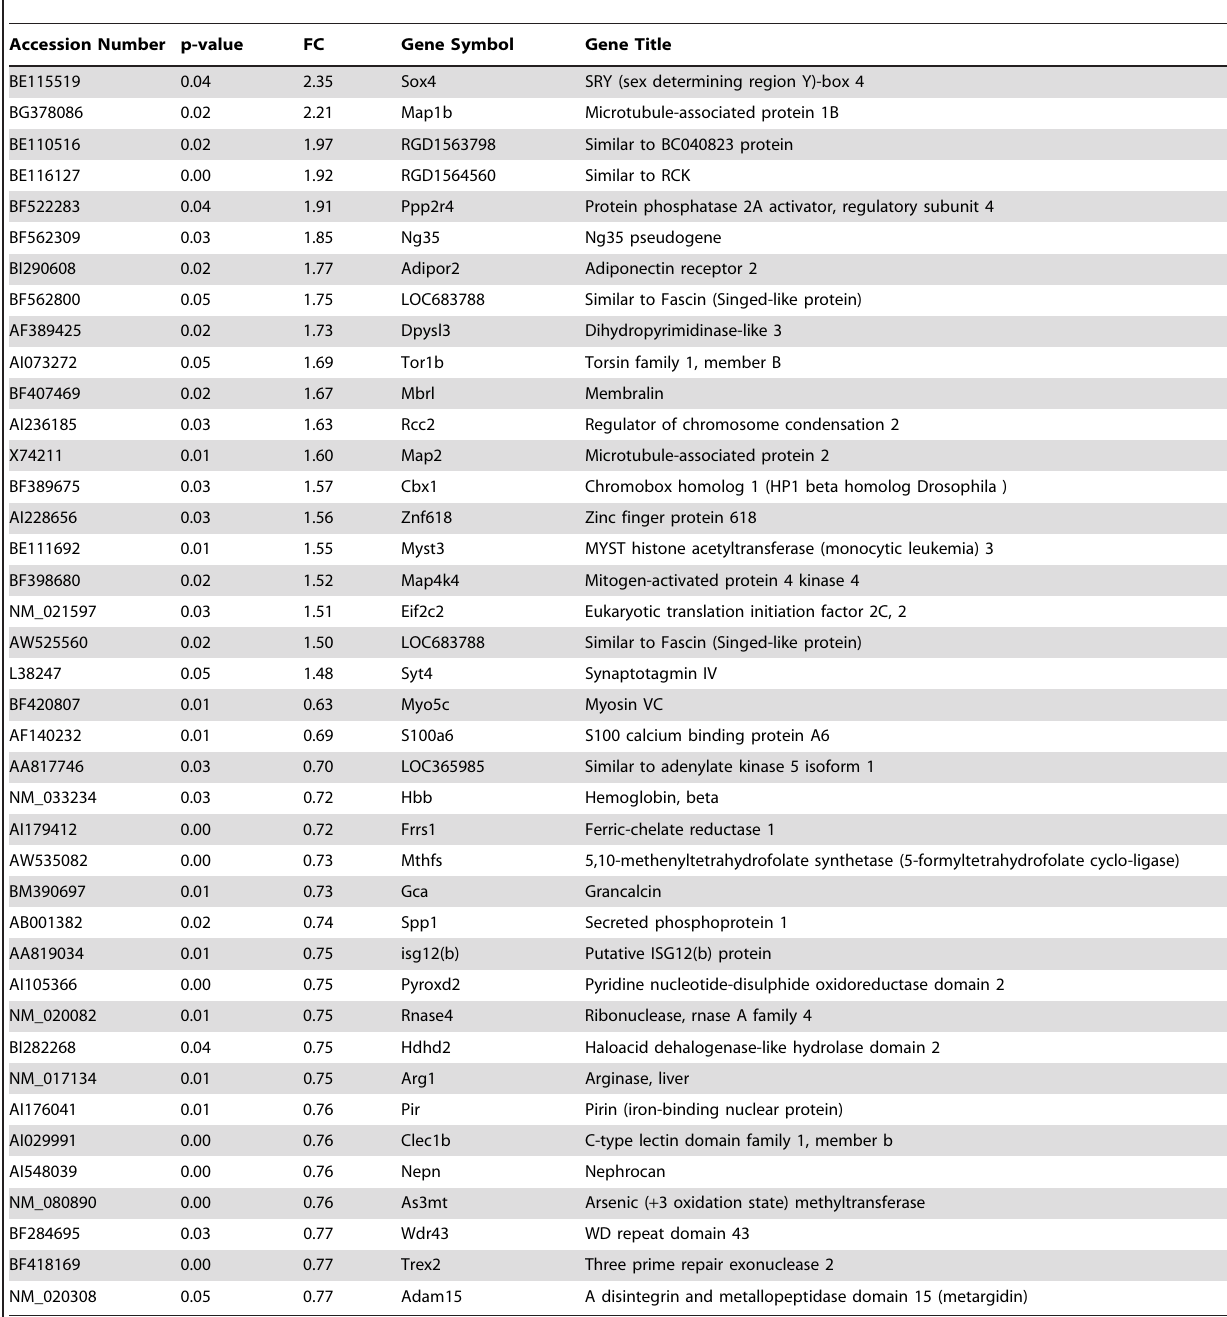
Table 2. Genes showing the greatest increase or decrease in expression in FeD embryos (n= 8) relative to controls. FC =fold-